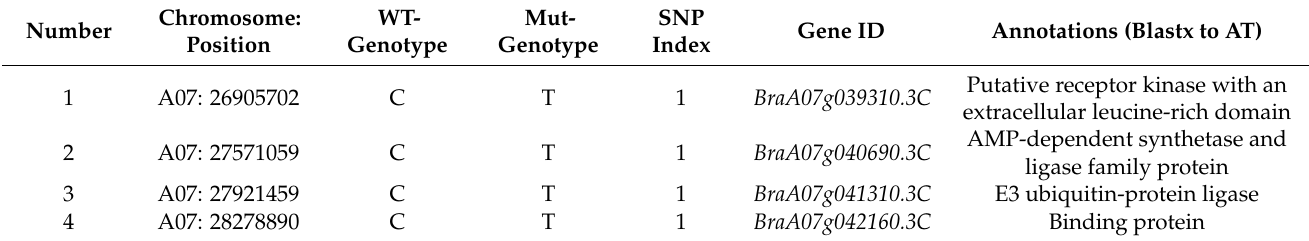
Table 2. Candidate SNP information in the candidate region by Mutant